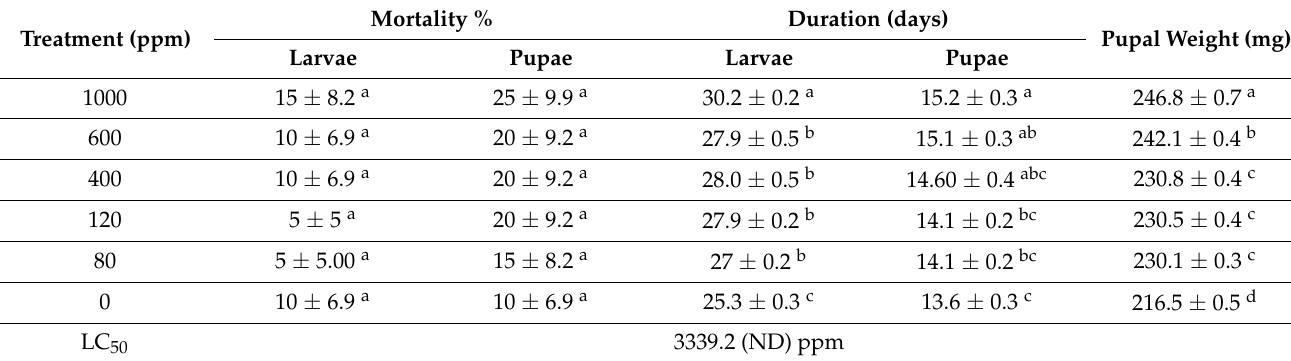
Table 3. Insecticide and insectistatic activity from pyrocatechol against Spodoptera frugiperda . Treatment